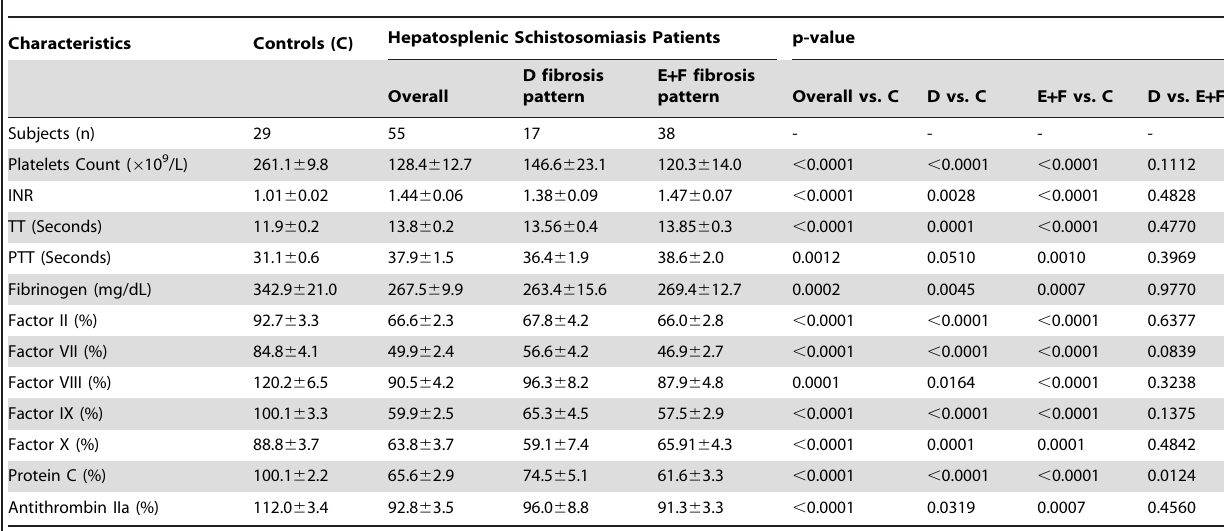
Table 2. Coagulation parameters from hepatosplenic schistosomiasis patients with different patterns of periportal fibrosis.